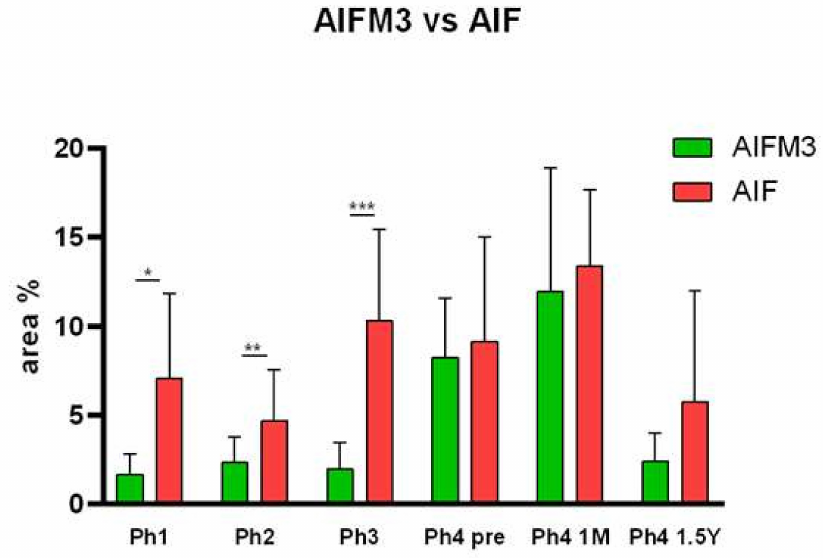
Figure 6. The area percentages of AIFM3 and AIF in human fetal and postnatal kidney cortex side by side comparison. Phase one (Ph1), phase two (Ph2), phase three (Ph3), phase four prenatal (Ph4 pre), phase four one month postnatal (Ph4 1 M), and phase four one and a half years postnatal (Ph4 1.5 Y). Data are presented as the mean ± SD (vertical line) and analyzed by the two-way ANOVA test with Tukey’s multiple comparisons test. Significant differences were indicated by * p < 0.05, ** p < 0.01, *** p <